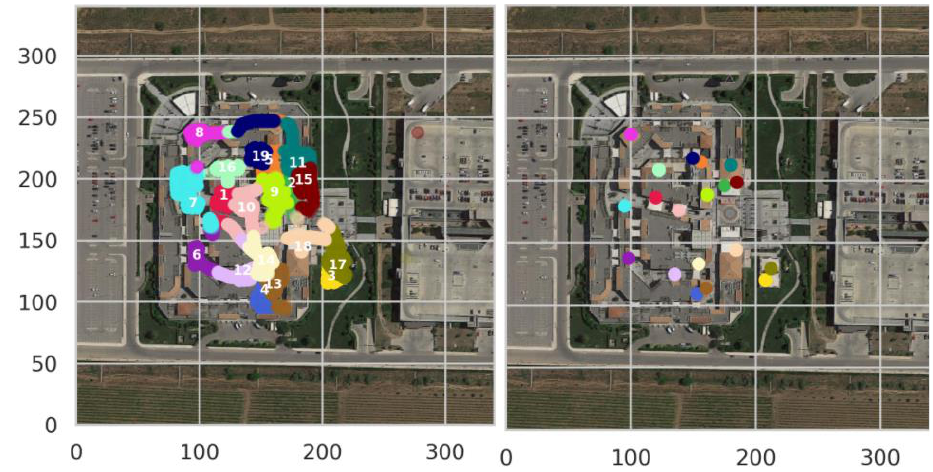
Figure 5. Spatial clustering generated zones ( left ) and centers ( right ).